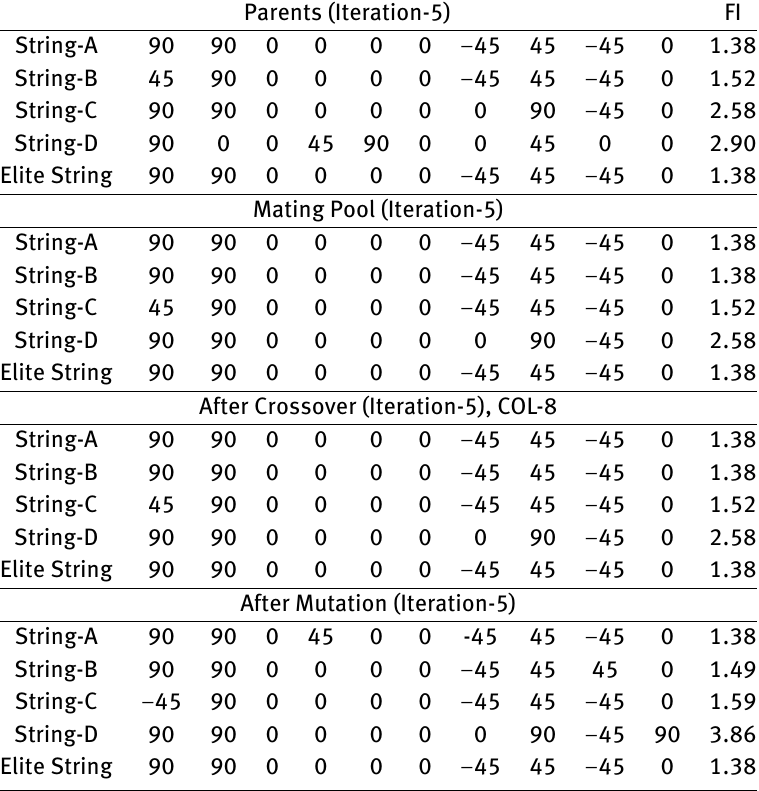
Table 8: GA Iteration-5